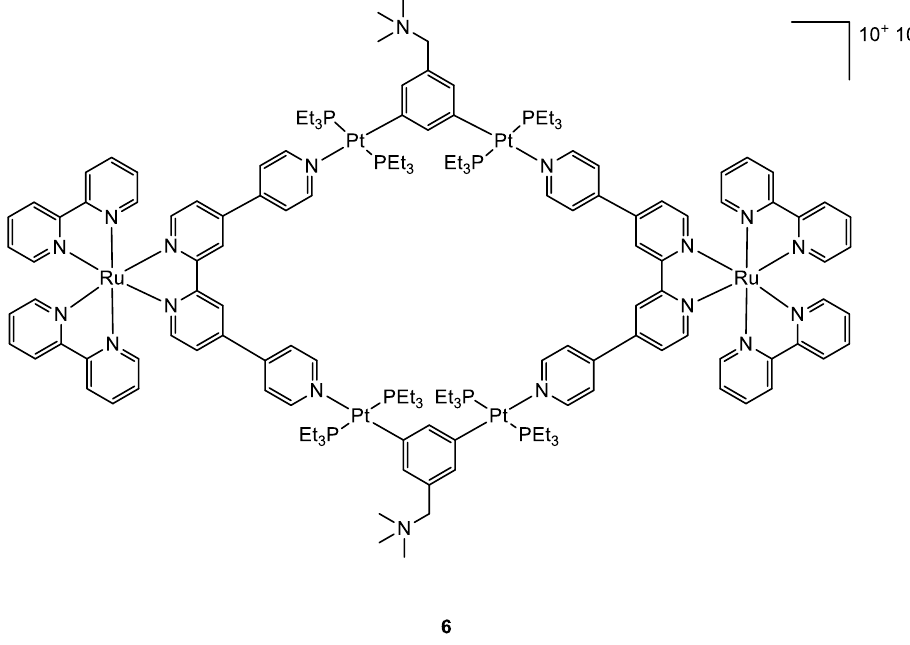
Figure 5. Molecular structure of compound 6 .